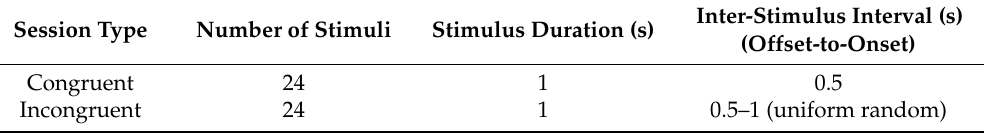
Table 1. Parameter values for presentation of Stroop color–word stimuli in experimental